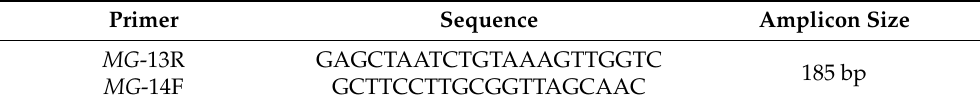
Table 1. Primer sequences for identification of MG